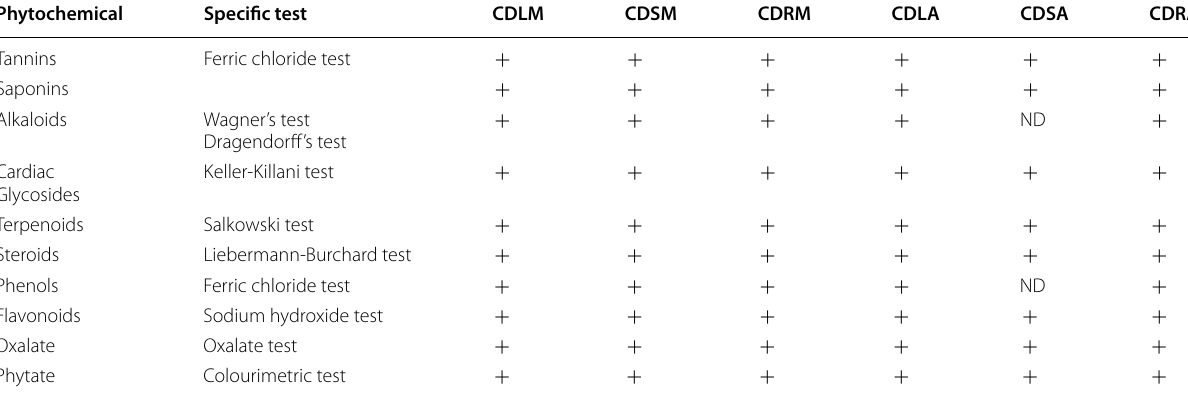
, present; ND, not detected; CDRM, C. dependens root methanol; CDLM, C. dependens leaves methanol; CDSM, C. dependens stem methanol; CDRA, C. dependens root + aqueous; CDLA, C. dependens leaves aqueous; CDSA, C. dependens stem aqueous